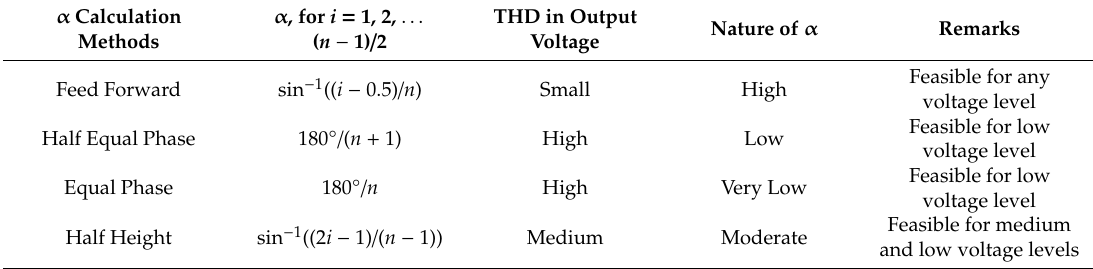
Table 5. Comparative analysis of di ff erent switching angle calculation (SAC) methods